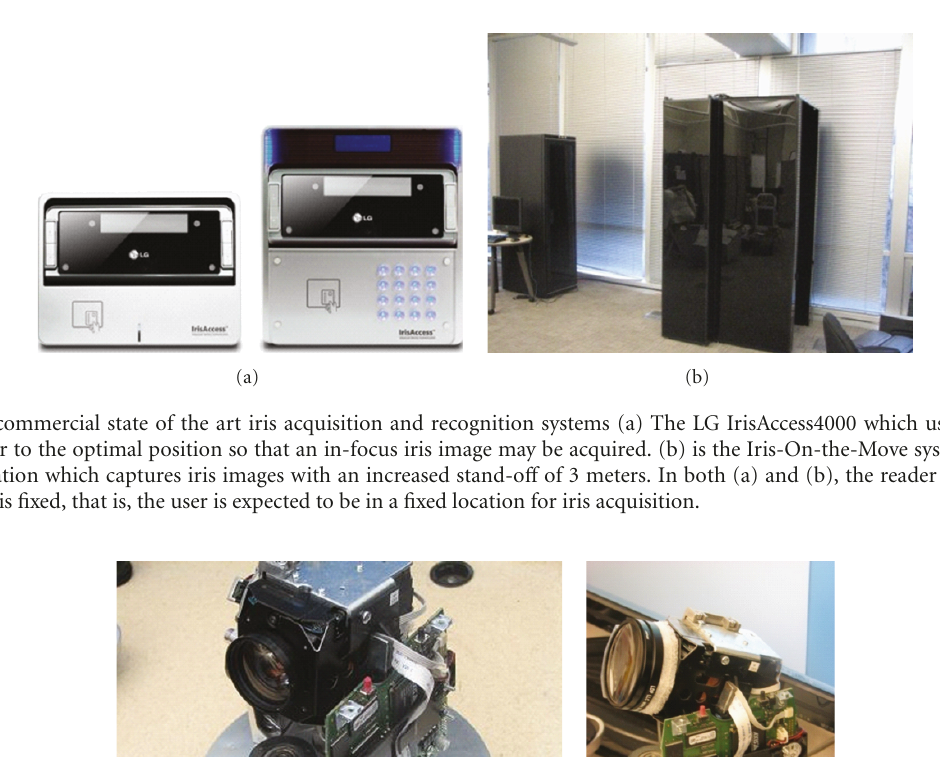
Pan-Tilt-Zoom (PTZ) camera manufactured by Axis